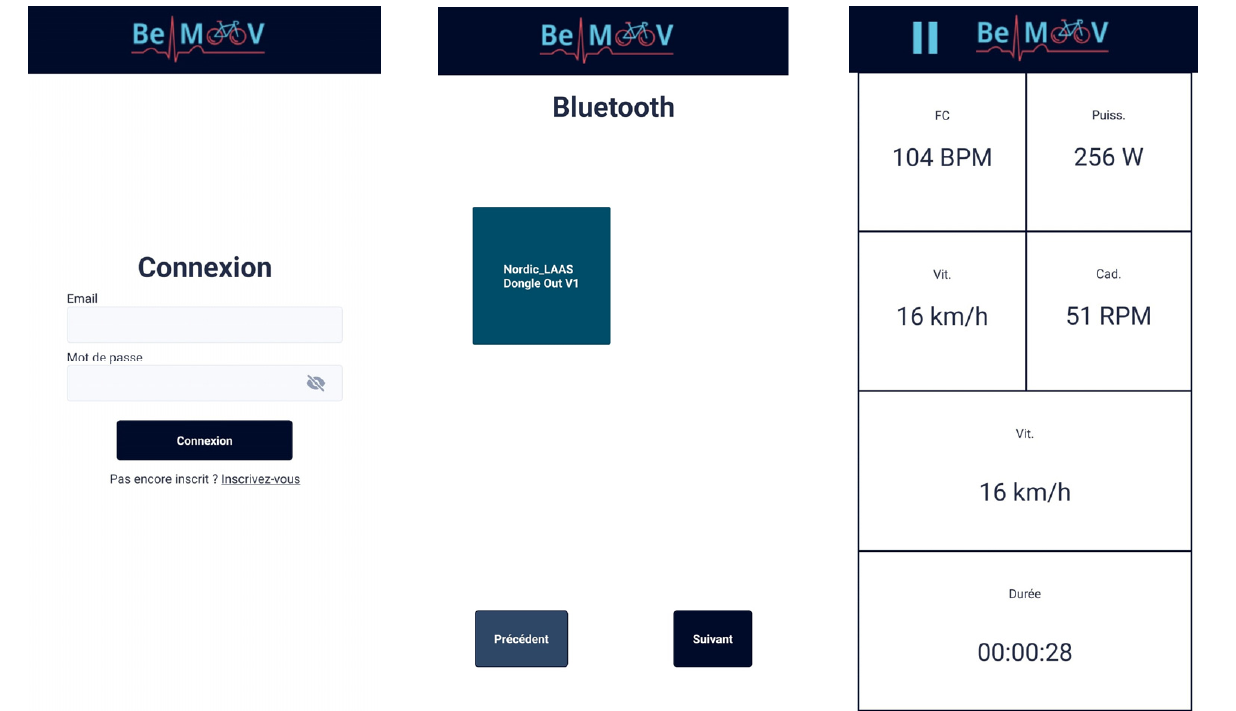
Figure 5. Screen captures from the application.